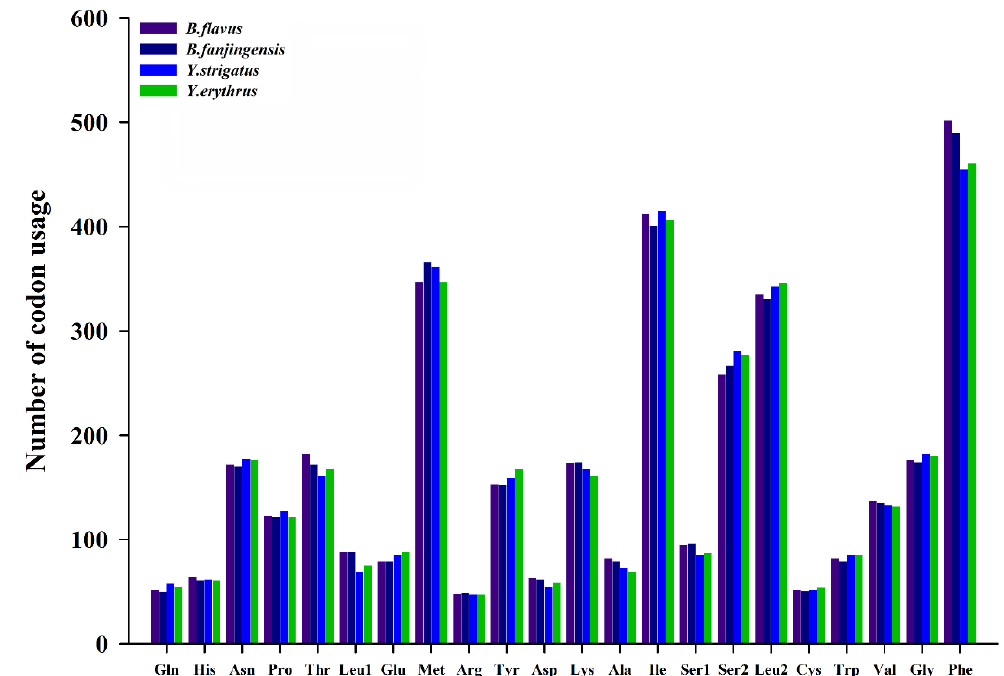
Figure 2. Number of codon usages in the protein-coding genes of Bambusicaliscelis flavus , B. fanjingensis , Youtuus strigatus , and Y. erythrus mitogenomes. Each amino acid is denoted as a three-letter symbol according to the IUPAC-IUB three-letter amino acid codes.